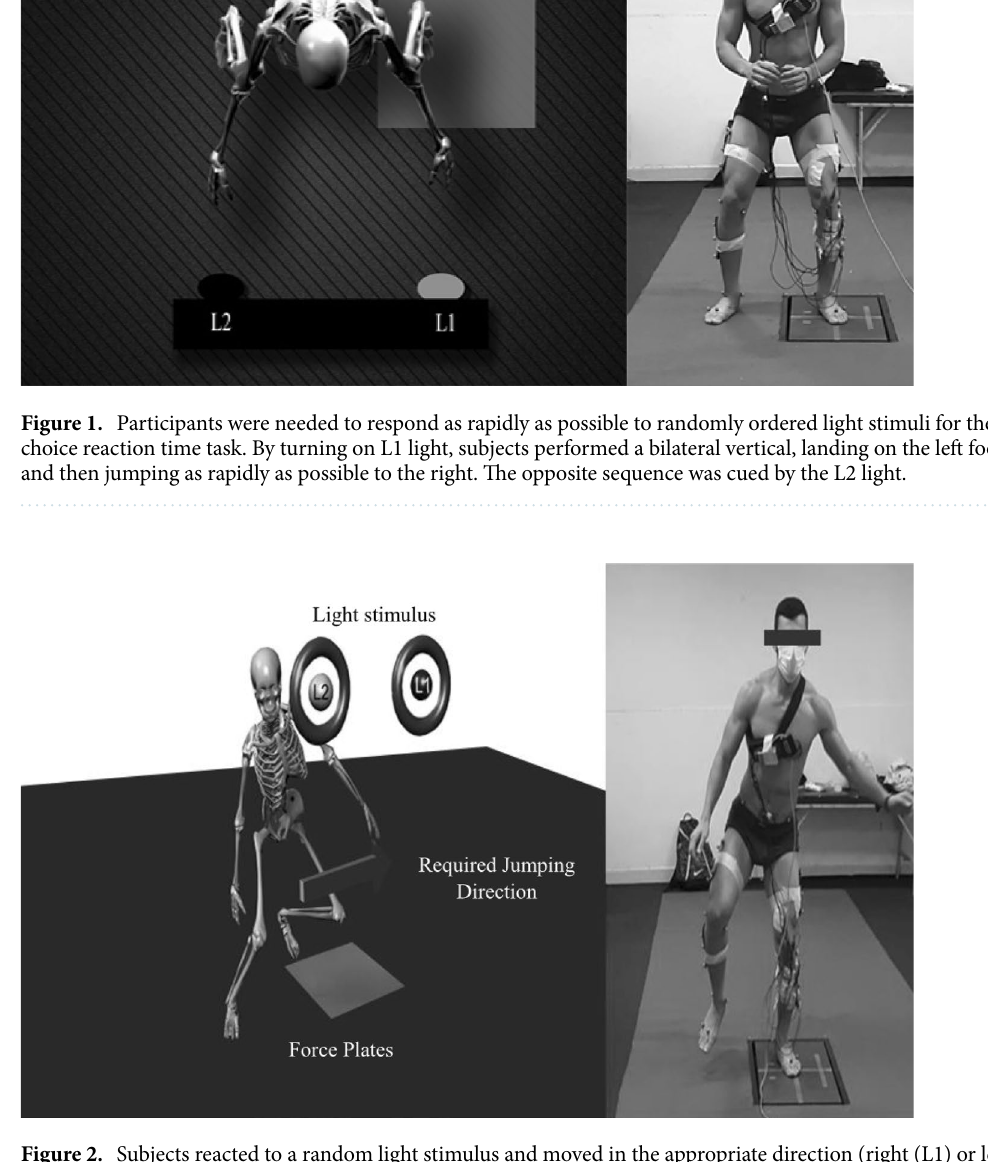
Figure 2. Subjects reacted to a random light stimulus and moved in the appropriate direction (right (L1) or left (L2) upon landing on the cued